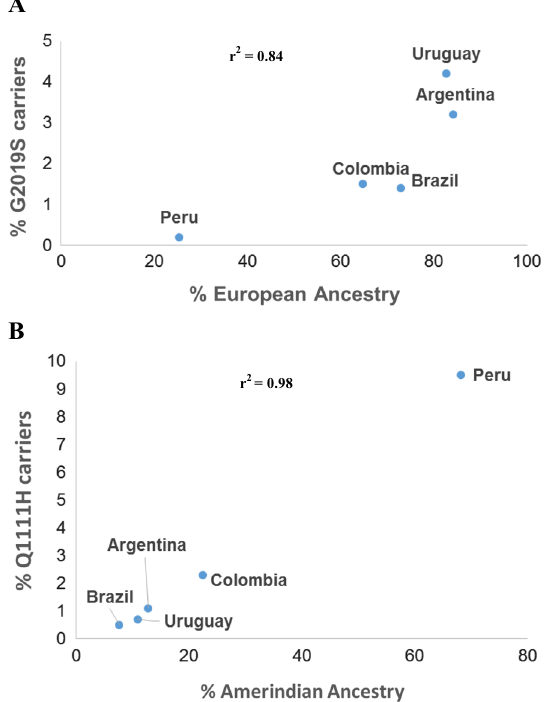
Fig. 1 Correlation between frequency of a p.G2019S and b p. Q1111H carriers and the proportion of European or Amerindian admixture in the cohort from each site. Correlation is shown in each of the fi gures as the coef fi cient of determination ( r 2